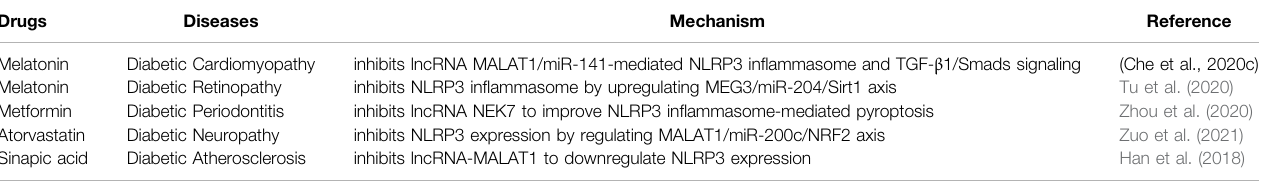
TABLE 3 | Mechanism of drugs treating diabetic complications. Drugs Diseases